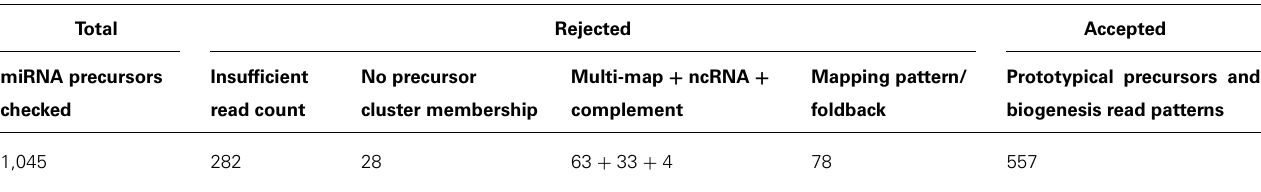
Table 1 | Summary of miRNA review.